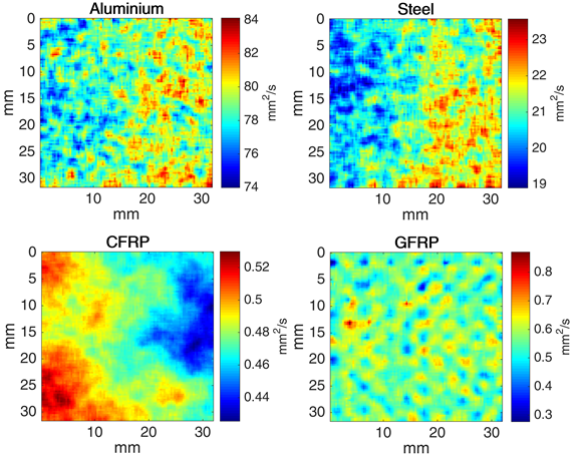
Figure 5. Thermal diffusivity distribution map representing one selected sample from all four materials using the NLSF method.